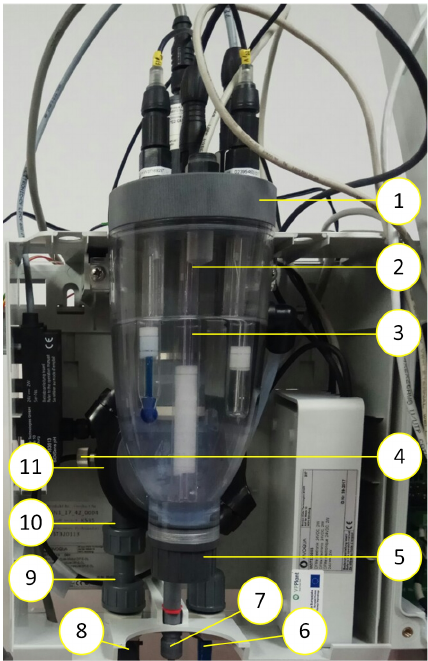
Figure 5. Measuring probes tank list of elements: 1: cover, 2: Housing, 3: Cell body, 4: Multisensor, 5: Flow distribution cap, 6: Sample water outlet, 7: Sample extraction unit, 8: Sample water inlet, 9: Filter unit, 10: Check valve housing, 11: Glow control